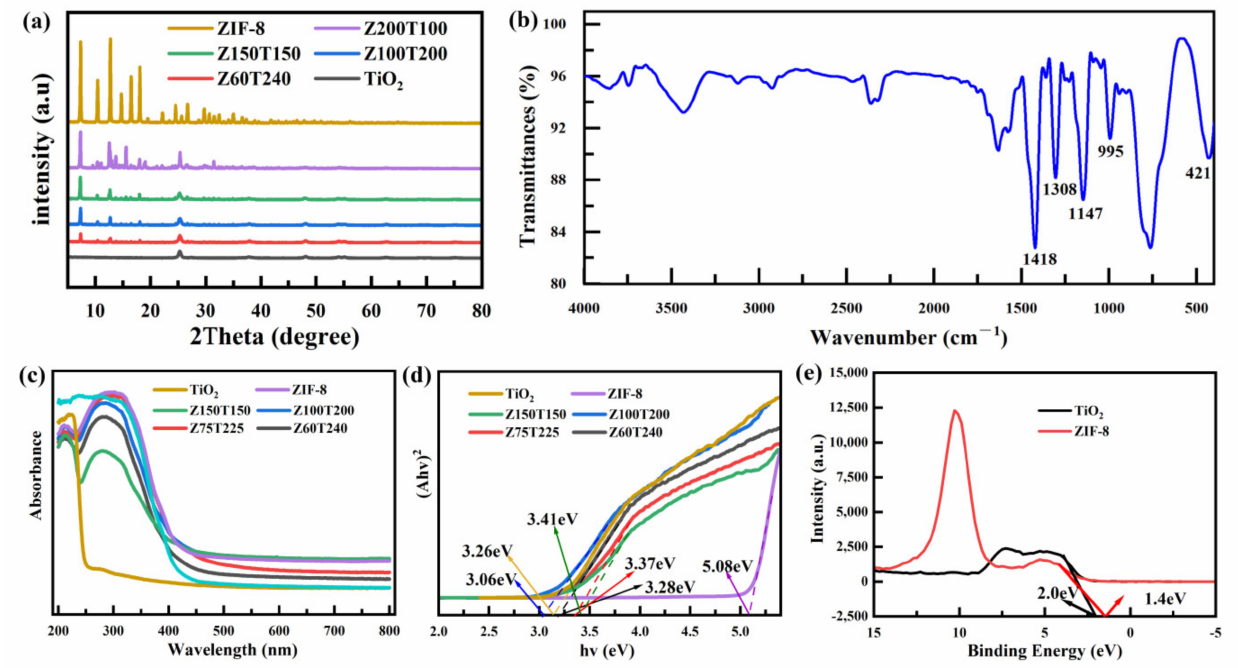
Figure 3. ( a ) XRD patterns, ( b ) FTIR spectrum, ( c ) UV-visible absorption spectra, ( d ) Optical band gap energy plots and ( e ) Valence band XPS spectra of ZIF-8, TiO 2 or ZIF-8@TiO 2 (Z x T y ). The FTIR spectrum of Z100T200 is shown in Figure 3b. The vibration bands at 1418 cm − 1 and 995 cm − 1 originated from the stretching vibration of C-N bond. The other evident peaks located at 1147 cm − 1 and 1308 cm − 1 correspond to the bending vibra- tion of imidazole. Another characteristic peak of ZIF-8 at 421cm − 1 was associated with the stretching vibration of the Zn-N bond. These results further indicated that TiO 2 was successfully coated on the surface of ZIF-8